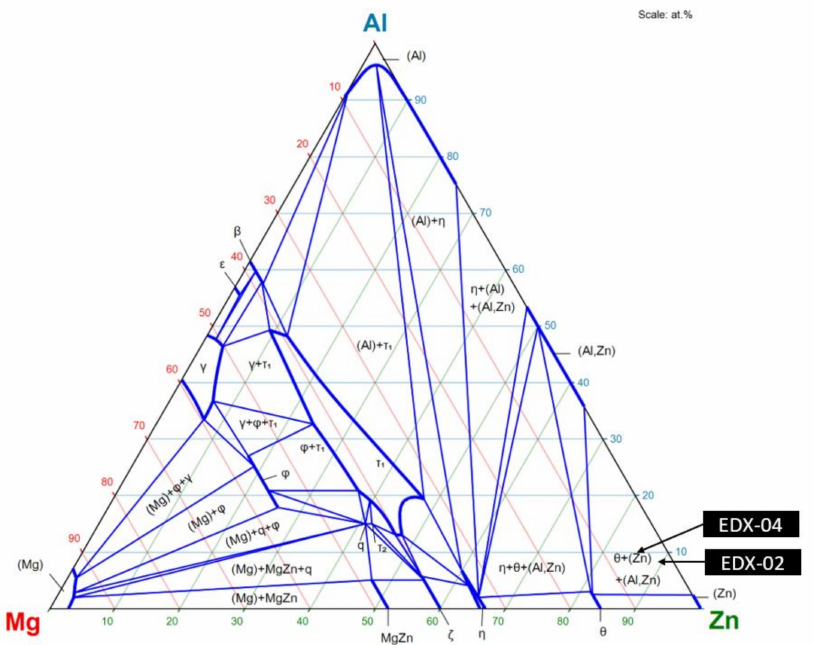
Figure 8. Isothermal section of the ternary system Al-Mg-Zn at 335 ◦ C with EDX points [26]. Due to the relatively high Si content, the measuring point EDX 04 was additionally classified according to the isothermal section of the ternary system Al-Si-Zn at 300 Al-Si-Zn system indicated a crystal mixture of Al, Si, and Zn mixed crystals, according to Figure 9.